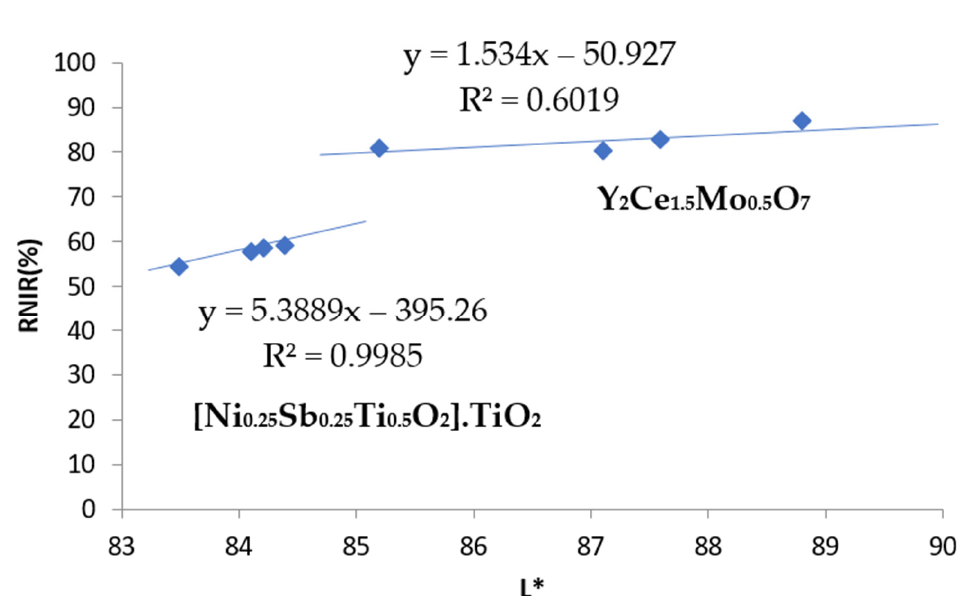
Figure 9. R NIR versus lightness L* of yellow pigments with gradual addition of the binder CaCO 3 . (d) Concerning black pigments, from the data in Figure 6, the chroma C* is lower for chromite-rutile black-green (C* = 6.5 vs. 9.6 for Sr 4 Mn 2 CuO 9 ), indicating a better black colour, and the hue is on the green range for this pigment (h* = 116.6), whereas the hue of black-brown Sr 4 Mn 2 CuO 9 falls into the brown range (h* = 41.2). Lightness is low and similar for both dark pigments (44–50), although it is too high to be pure black pigment, since they do not enter into the range proposed above (L* = 30 − 0). Moreover, the Sr 4 Mn 2 CuO 9 black-brown shows higher R NIR (51% versus 21% for chromite-rutile black-green). Finally, the evolution of colorimetry and reflectance data with the gradual addition of CaCO 3 binder to the pigments are shown in Table 5, and the representation of R NIR versus lightness L* follows a linear relationship in Figure 10. The R NIR 30 (reflectance associated to a L* = 30, considered for black hues) is 50% for Sr 4 Mn 2 CuO 9 black-brown pigment and 13% for chromite-rutile black-green. Therefore, Sr 4 Mn 2 CuO 9 shows better performance as cool pigment. Table 5. Colorimetry and reflectance parameters for CaCO 3 addition to black pigments.